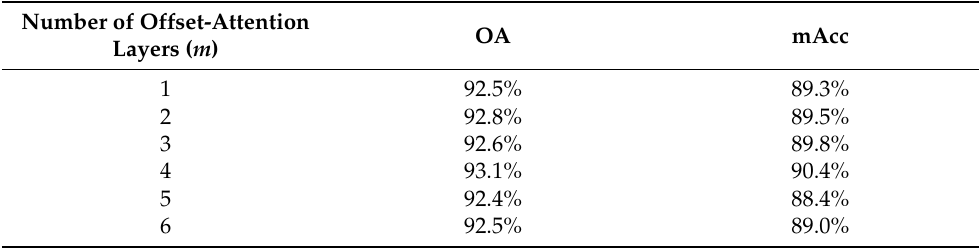
Table 7. Ablation study: classification accuracy of TR-Net on ModelNet40 test set using m stacked offset-attention layers.